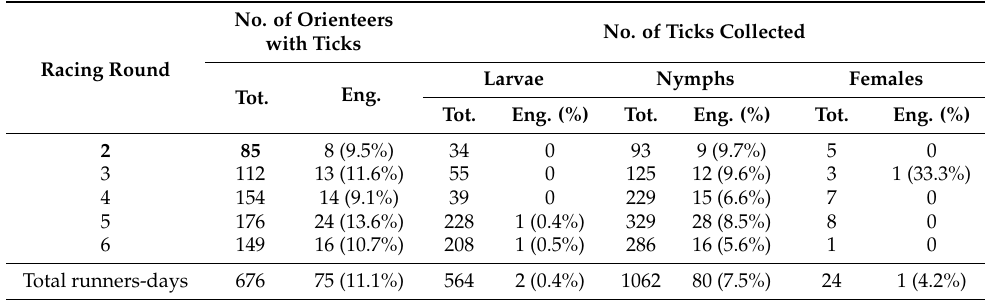
Table 2. Data summary of the total number of ticks and substantially engorged ticks submitted by orienteers participating in the study. Tot.: Total, Eng.: engorged. No. of Orienteers No. of Ticks Collected with Ticks Racing Round Larvae Nymphs Females Tot. Eng. Tot. Eng. (%) Tot. Eng. (%) Tot. Eng. (%) 2 85 8 (9.5%) 34 0 93 9 (9.7%) 5 0 3 112 13 (11.6%) 55 0 125 12 (9.6%) 3 1 (33.3%) 4 154 14 (9.1%) 39 0 229 15 (6.6%) 7 0 5 176 24 (13.6%) 228 1 (0.4%) 329 28 (8.5%) 8 0 6 149 16 (10.7%) 208 1 (0.5%) 286 16 (5.6%) 1 0 Total runners-days 676 75 (11.1%) 564 2 (0.4%) 1062 80 (7.5%) 24 1